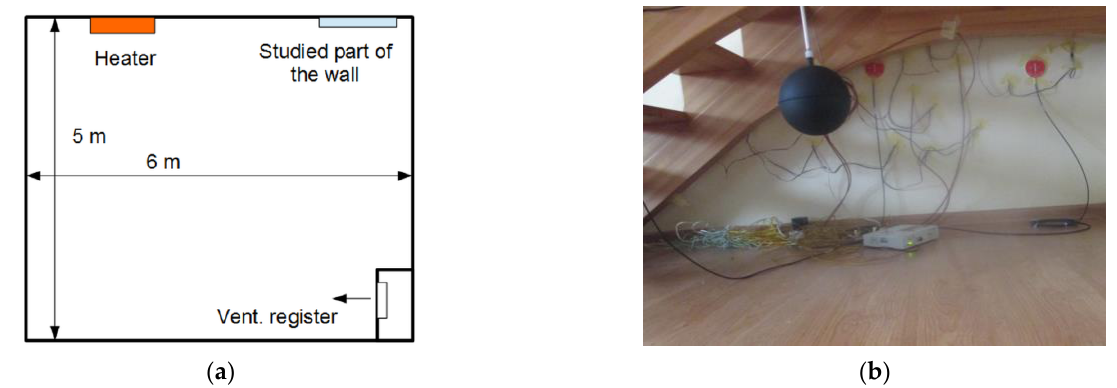
Figure 3. ( a ) View of the room selected for experiment; ( b ) View of the measurement equipment during assembly. The measured data was recorded in 10 min intervals with a MS6D Comet data logger.